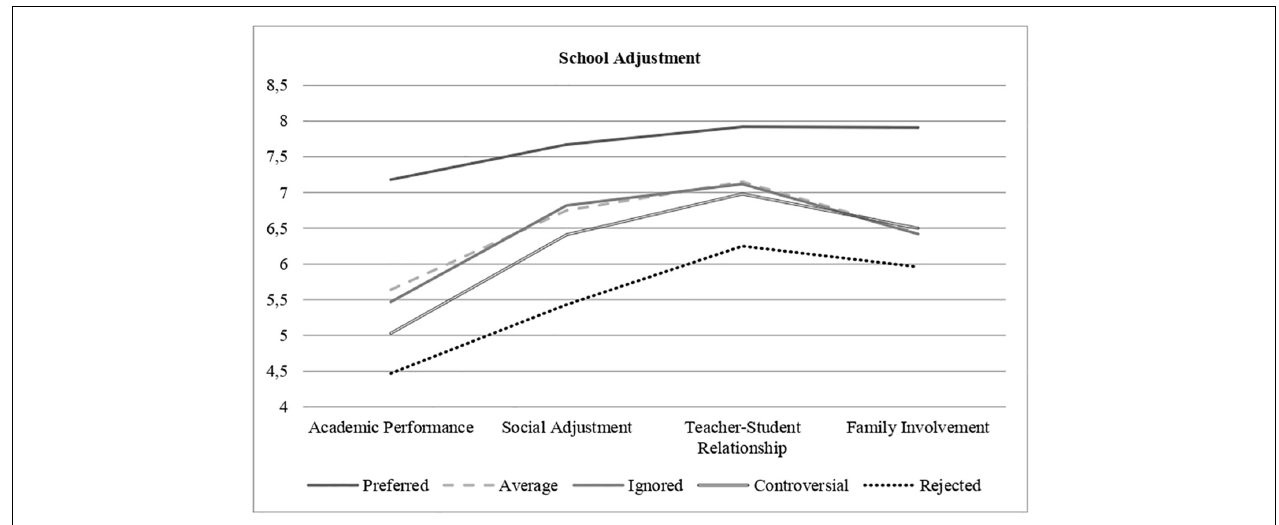
FIGURE 1 | School adjustment and Sociometric status.